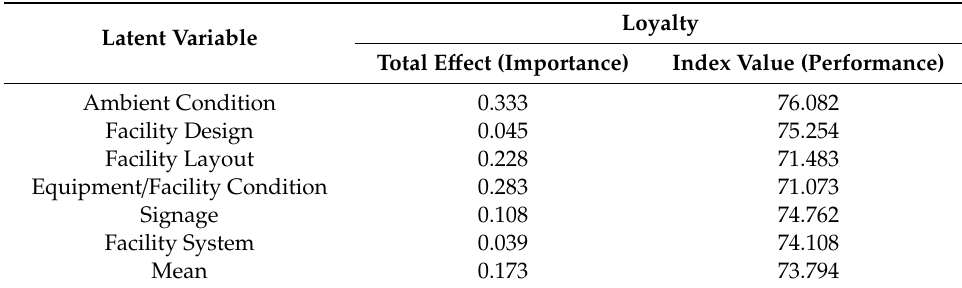
Table 6. IPMA results full data